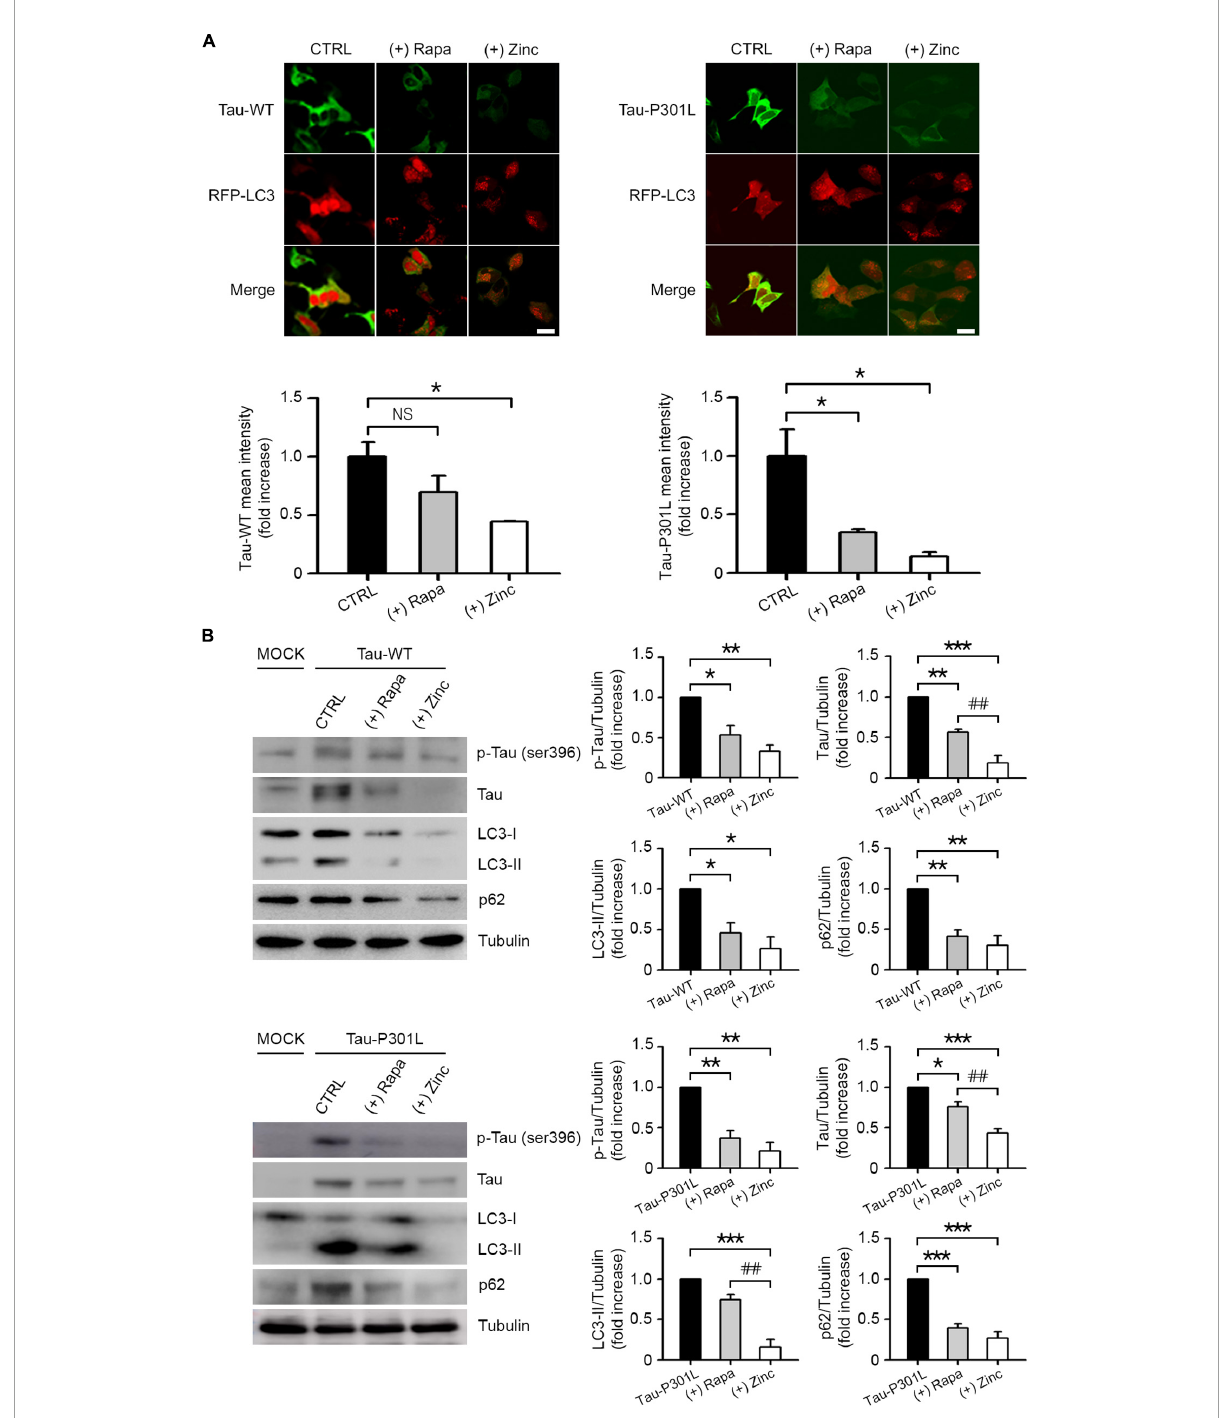
FIGURE7 Zinc-activated lysosomal function and autophagic flux contribute to the degradation of wild-type tau or mutant tau(P301L). (A) SK-N-BE(2)-C neuroblastoma cells expressing RFP-LC3 were transiently transfected with GFP-Tau-WT (Tau-WT) or GFP-Tau-P301L (Tau-P301L). Fluorescence confocal microscopy images of SK-N-BE(2)-C cells at 6 h after sham wash (CTRL), or exposure to 400 nM rapamycin (+Rapa) or 30 µ M ZnCl 2 (+Zinc). The bar graph represents the fluorescence intensity of GFP-Tau-WT or GFP-Tau-P301L (mean ± SEM, taken from ≥ 3 independent biological replicate experiments). Scale bar: 10 µ m. * p < 0.05 by ANOVA with post hoc Bonferroni’s test. (B) Western blot analysis for phospho-tau at Ser396, tau, LC3, and p62 in SK-N-BE(2)-C neuroblastoma cells transiently expressing GFP-Tau-WT (Tau-WT) or GFP-Tau-P301L (Tau-P301L). Protein samples were prepared at 6 h after exposure to sham wash (CTRL), 400 nM rapamycin (+Rapa), or 30 µ M ZnCl 2 (+Zinc). Tubulin was used as a loading control. Quantification of protein levels of p-tau, tau, LC3-II, and p62 was performed in ≥ 3 independent biological replicate experiments. * p < 0.05, ** p < 0.01, *** p < 0.001 or **** p < 0.0001 vs. control and ## p < 0.01 vs. rapamycin by ANOVA with post hoc Bonferroni’s